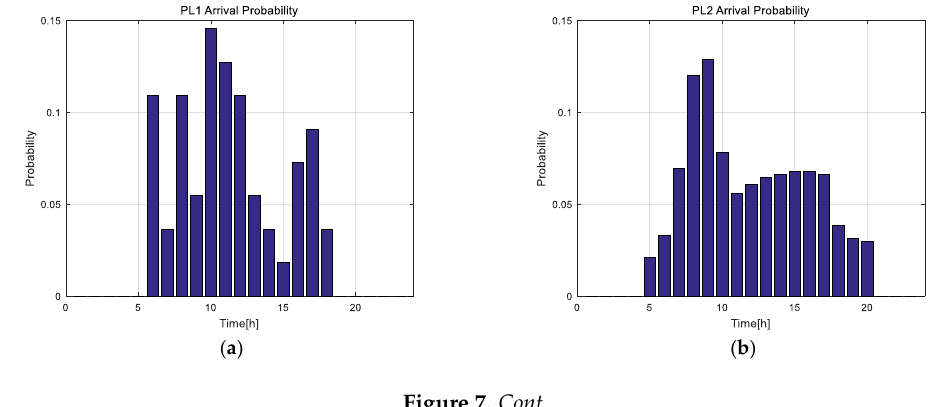
Table 2. IEEE 15 Bus System Line Data.